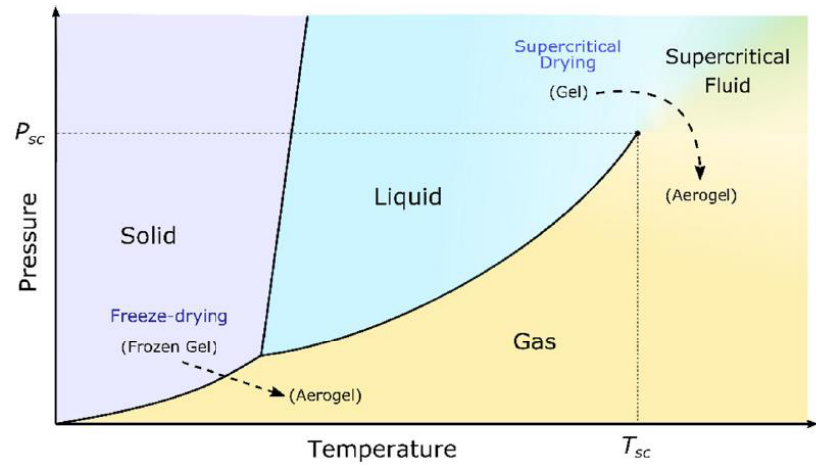
Figure 2. A unary phase diagram showing the temperature conditions for supercritical fluid drying and freeze drying. P sc defines the supercritical pressure and T sc represents the supercritical temperature in the diagram. Reproduced under the terms and conditions of the liberal Creative Commons Attribution 4.0 International (CC BY) license from [6]. Copyright © 2019 The Authors.